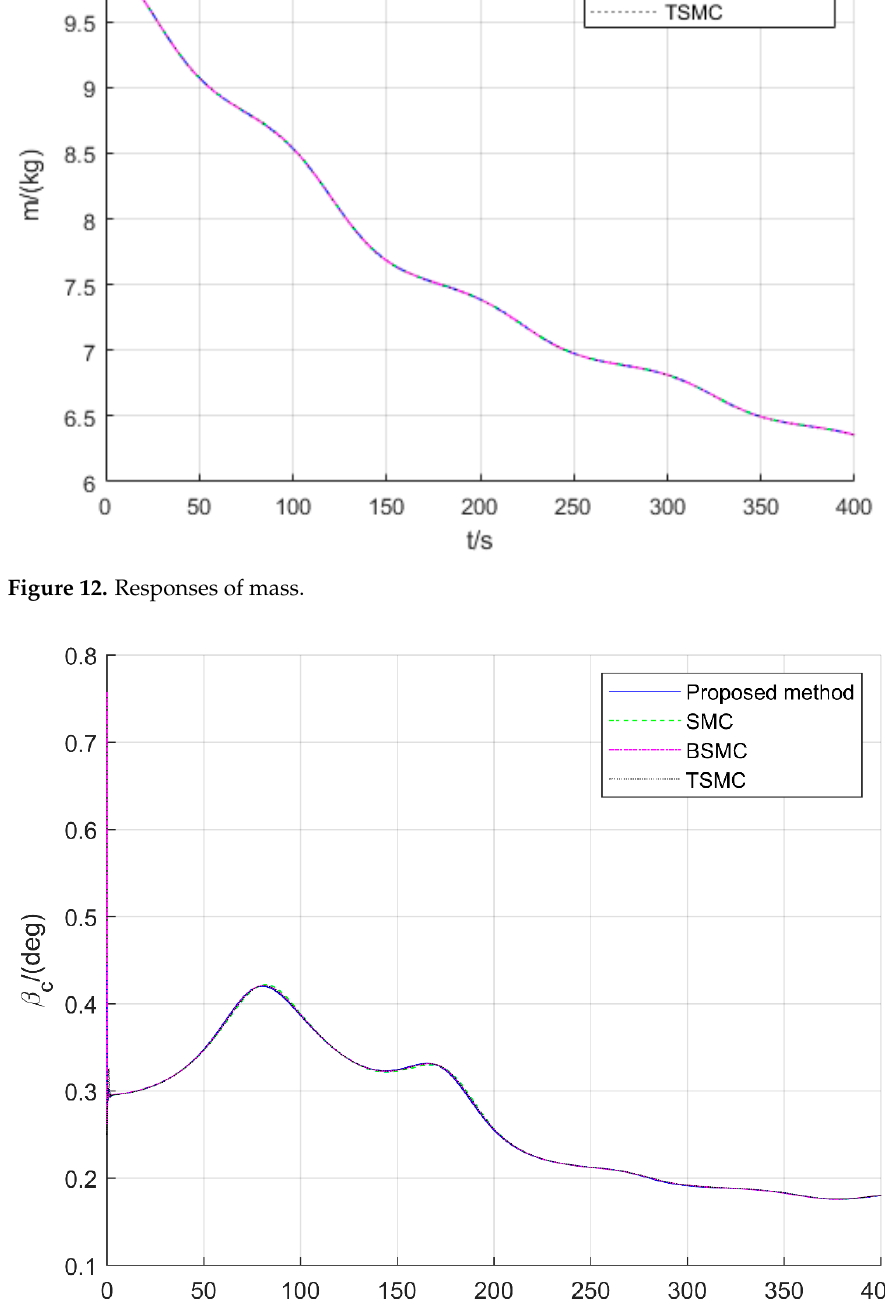
Figure 13. Responses of throttle setting.